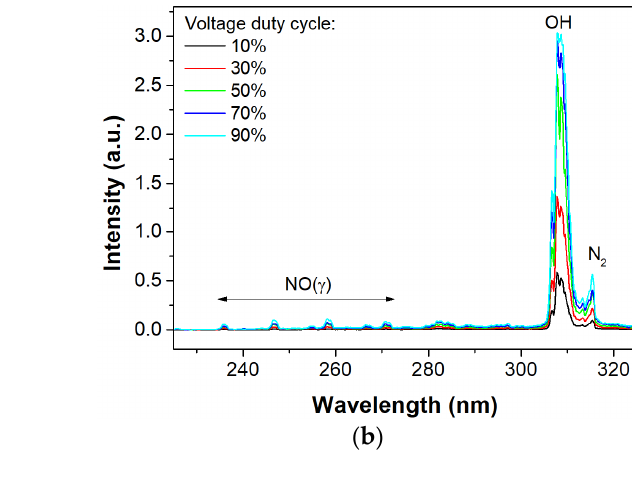
Figure 3. Temperature raised up to 5 min measured inside the reactor at the bottom central part of the glass Petri dish. A maximum error of ± 0.5 ◦ C for all data was considered.